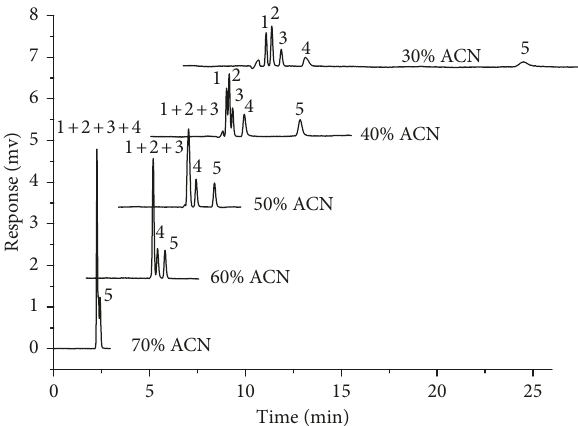
Figure 4: Effect of content of ACN on separation of 5-nitro- imidazole compounds. Electrochromatographic conditions: mobile phase: ACN/10mM sodium dihydrogen phosphate-disodium hydrogen phosphate buffer (pH 4.82). Other conditions and the order of peak can be seen in Figure